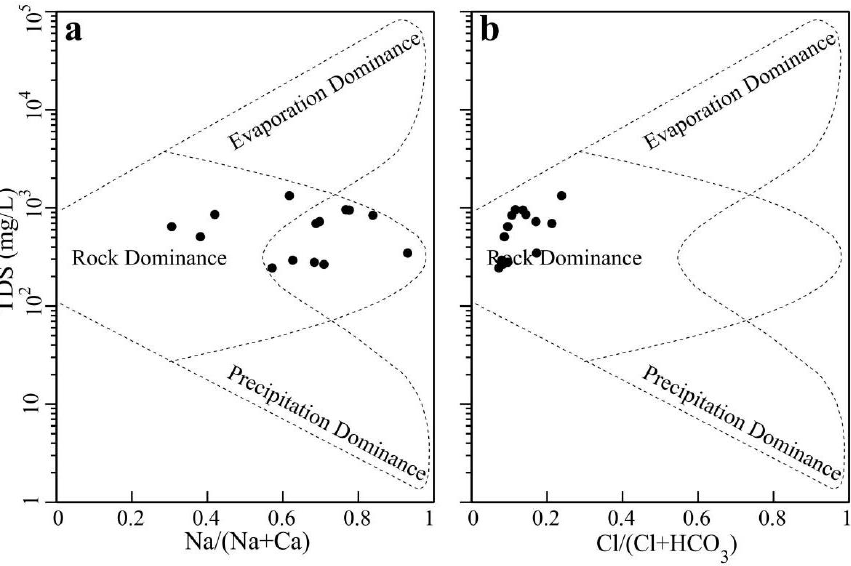
Figure 6. Gibbs diagrams, ( a ) TDS versus Na/(Na+Ca), ( b ) TDS versus Cl/(Cl+HCO 3 )